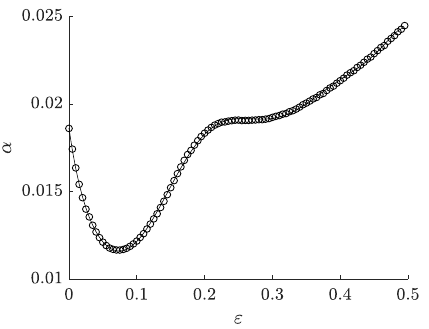
Figure 3. The values of α calculated from the T -averaged values of β and n (cid:48) as a function of strain.